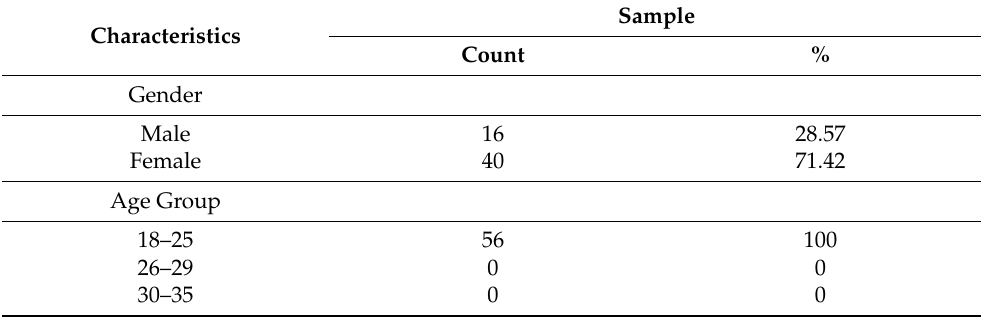
Table 2. Demographic of surveyed